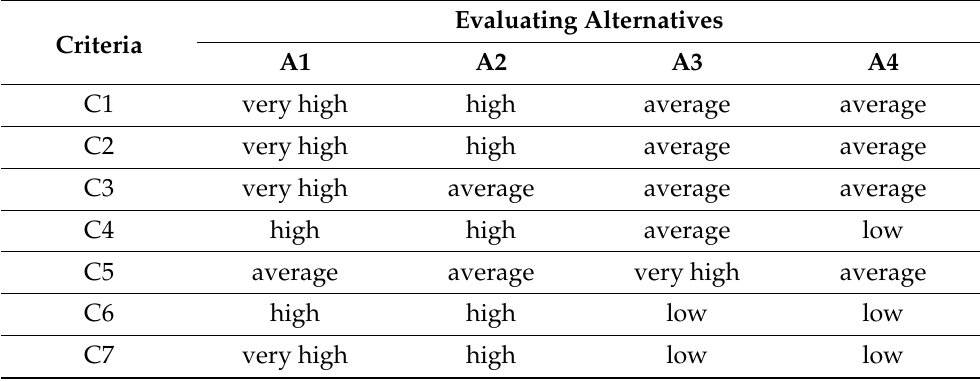
Table 5. Evaluation of the quality of alternatives according to the selected